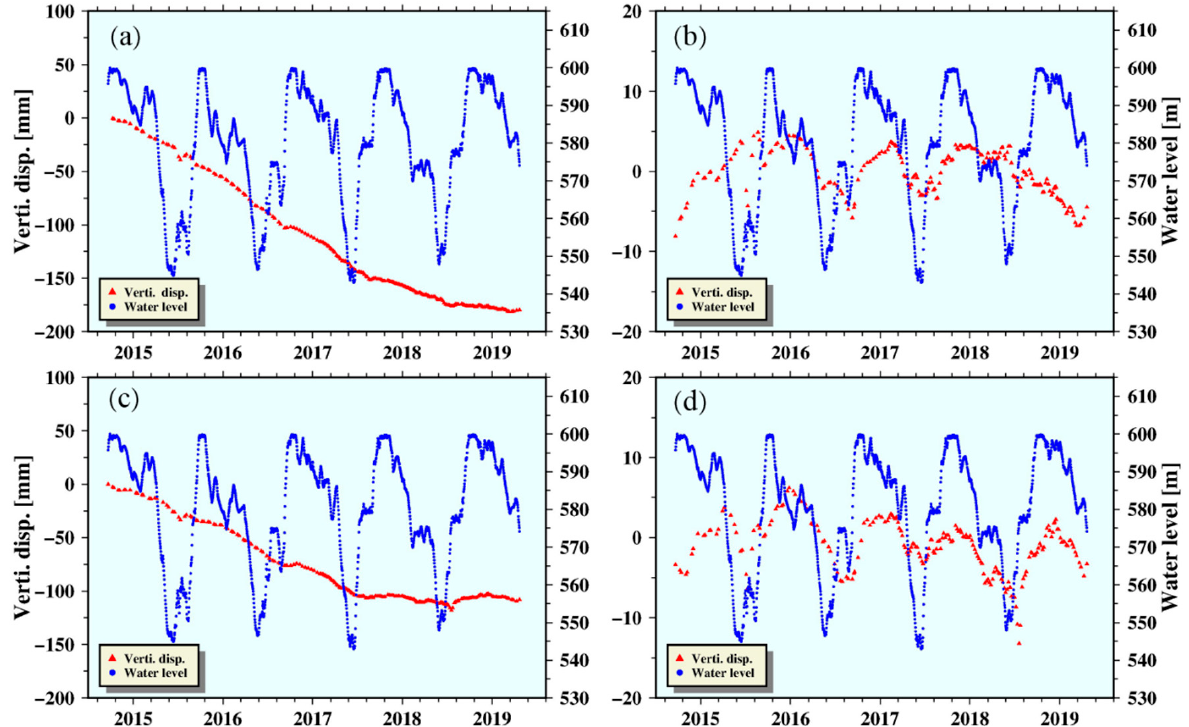
Figure 16. Relationship between vertical displacement and water storage. ( a ) is the relationship between the deformation sequence and water level in the vertical direction of point P1 in Figure 10; ( b ) is the deformation sequence in ( a ) that removes the linear trend; ( c ) is the relationship between the deformation sequence and water level in the vertical direction of point P2 in Figure 10; ( d ) is the deformation sequence in ( c ) that removes the linear trend.